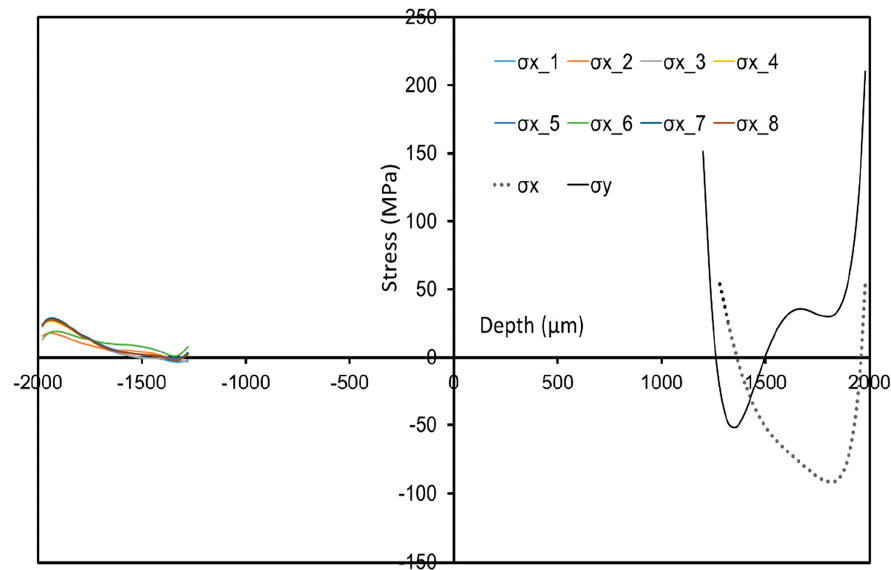
Figure 8. In-depth residual stress profile in the CFRP / metal hybrid component. Drilling has been conducted from both sides of the hybrid component separately. See text for details.